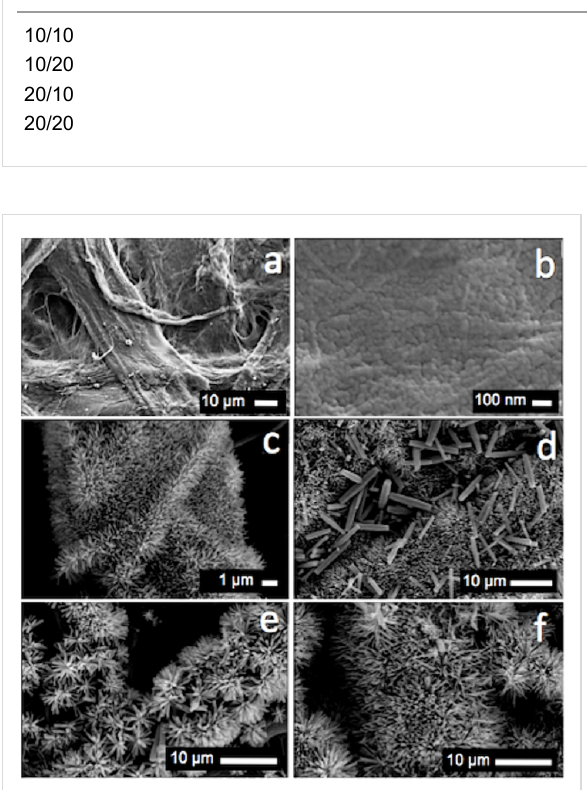
Figure 7a. The indexed planes confirm the wurtzite structure of ZnO (Figure 7b).